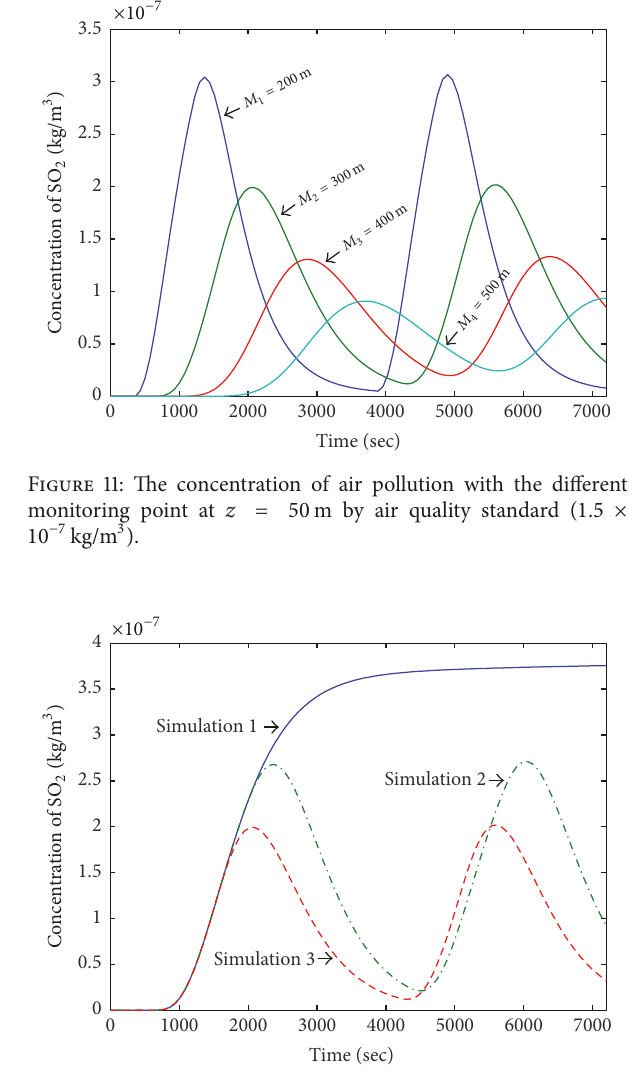
Figure 12: The air pollution concentration at 𝑧 = 50 m and 𝑥 = 300 m ( M 2) in three